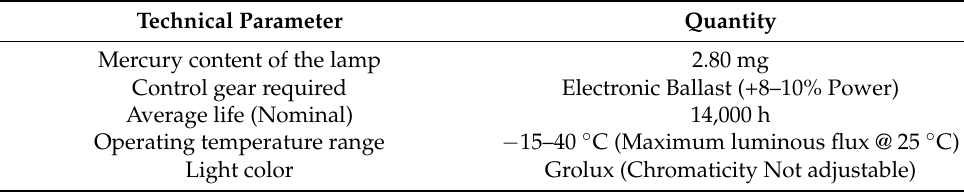
Table 3. Range of energy losses depending on the type of auxiliary ballast of fluorescent